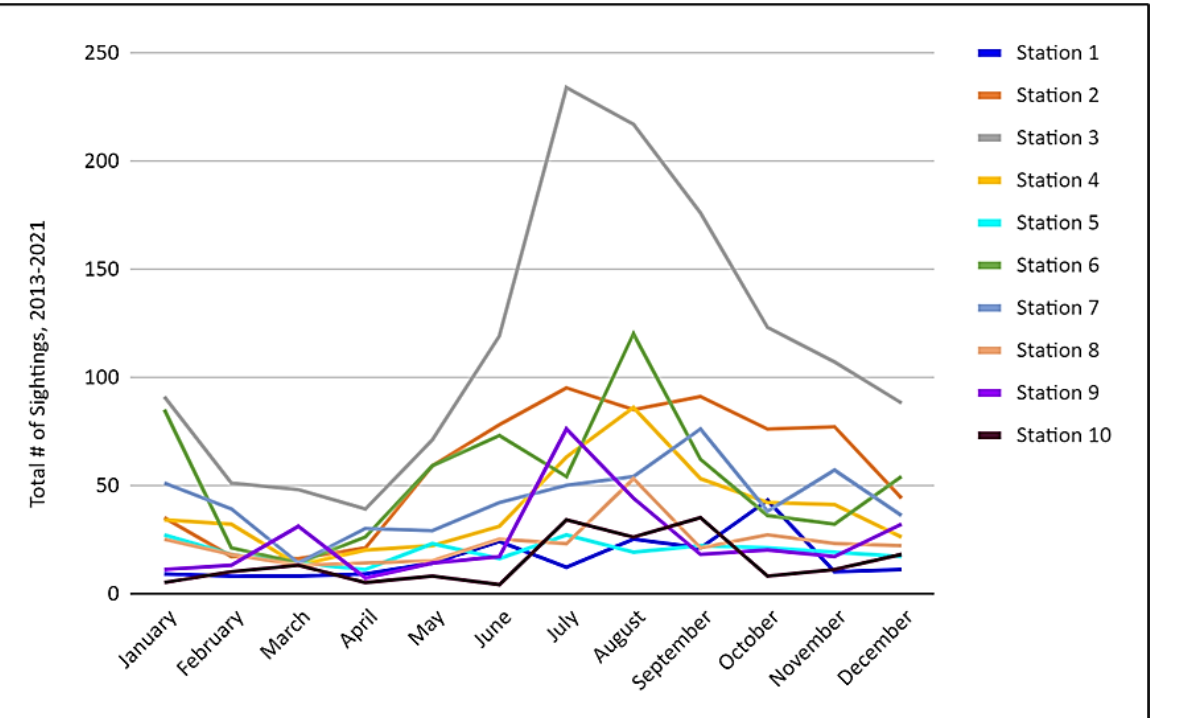
Figure 7. The mean proportions of sightings of green turtles at 10 observation stations along lower San Gabriel River, CA. Dark colors indicate higher values and vice versa.